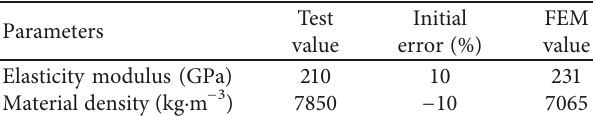
. (b) W q . qi Table 1: Parameters of test model and